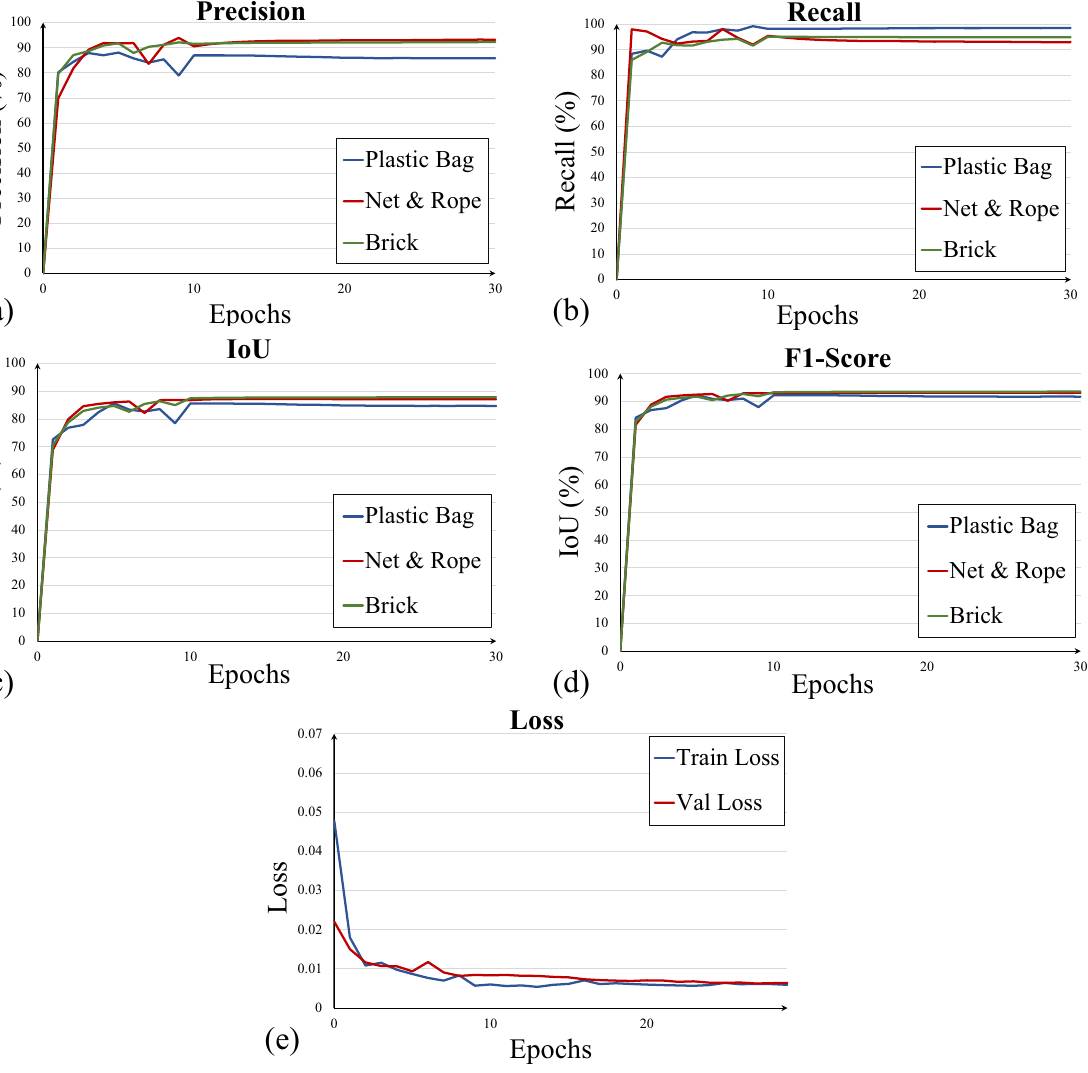
Figure 3. Evolutions of ( a ) precision, ( b ) recall, ( c ) IoU, ( d ) F1-score, and ( e ) the loss stabilization